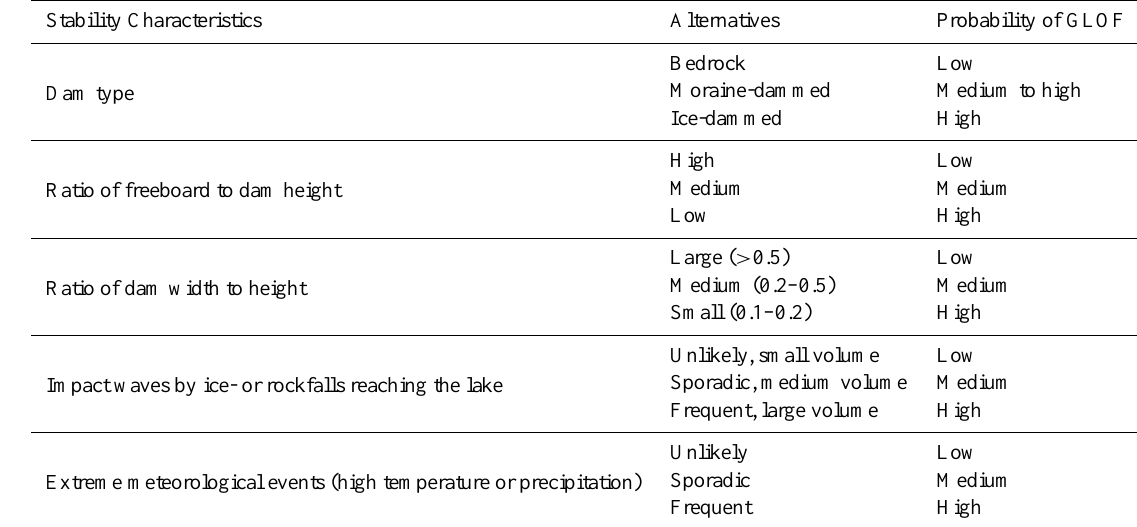
Table 4. The qualitative probability of a GLOF defined by Huggel et al. (2004).